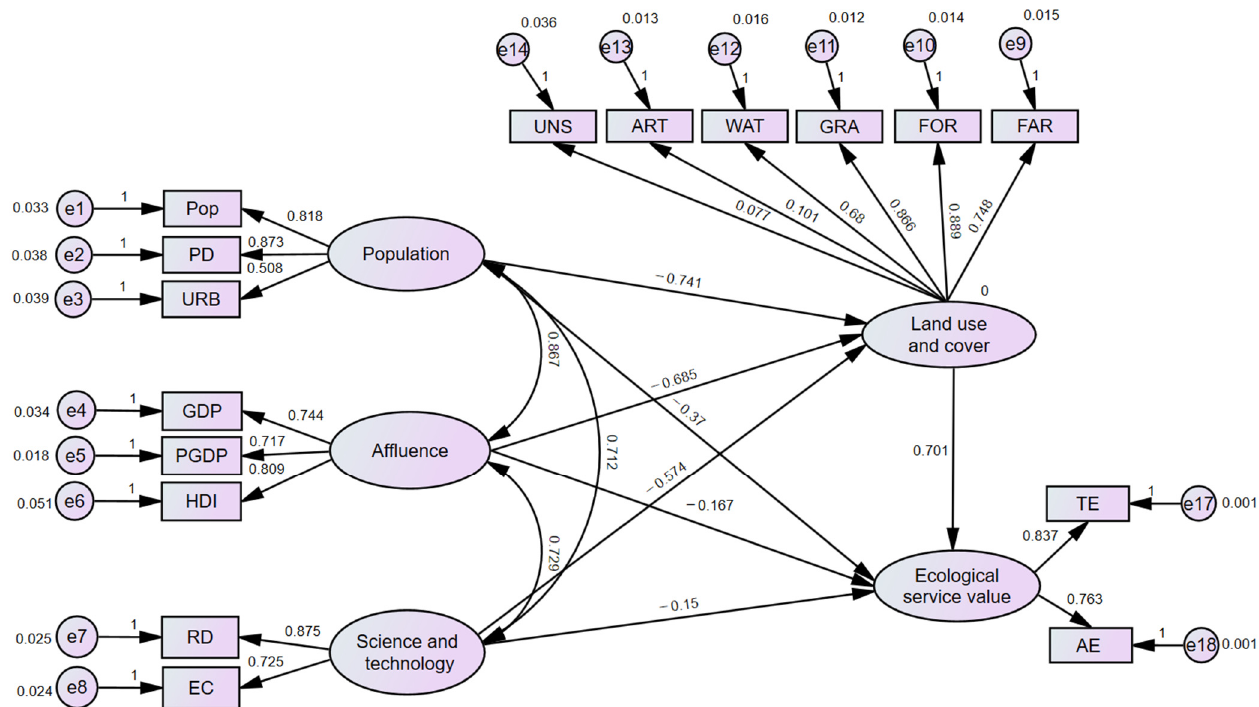
Figure 10. Structure diagram of load and path coefficient.